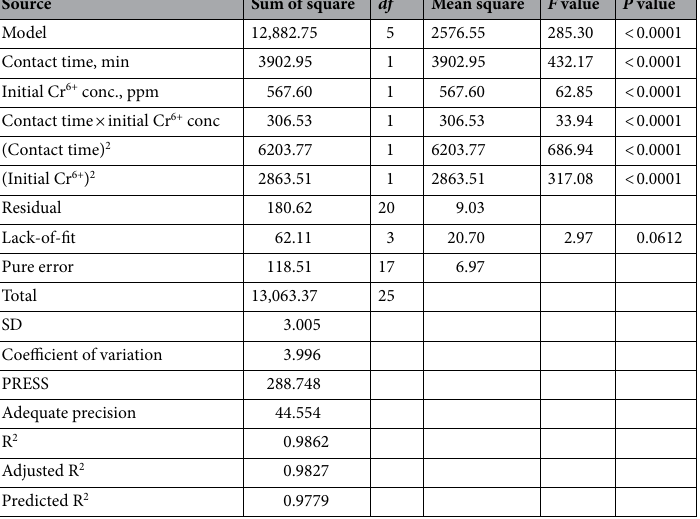
Table 5. ANOVA of Cr 6+ removal based on the experimental results of the RCCD matrix. df the degree of freedom, PRESS the sum of squares of prediction